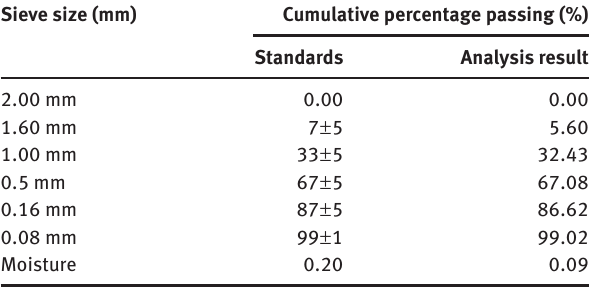
Table 3 Gradation of rilem sand.